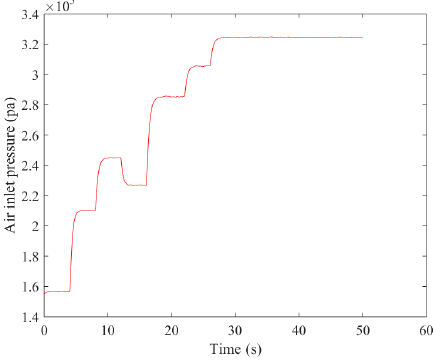
Figure 10. Air inlet pressure changes with time.